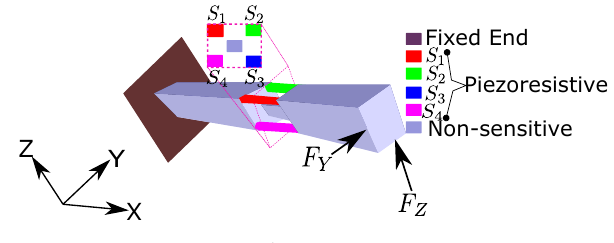
Figure 1. Sensing